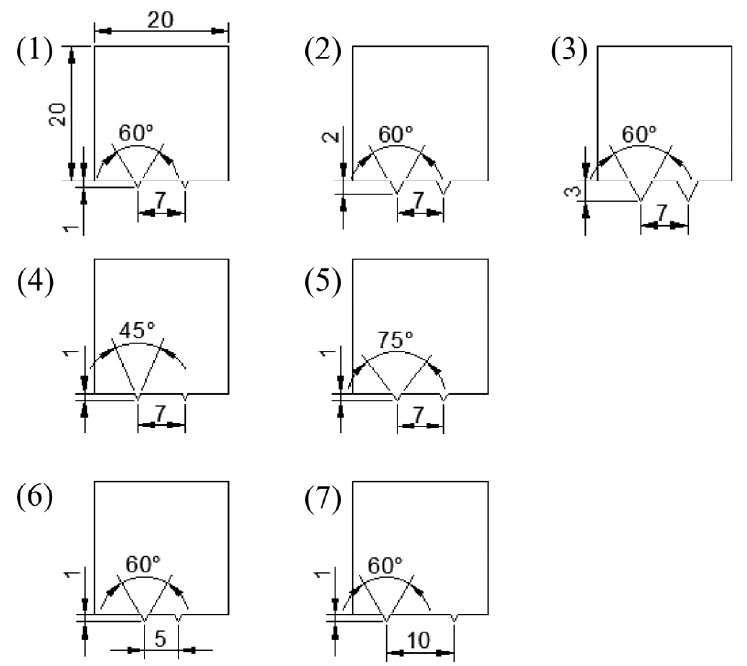
Figure 4. Seven types of shear indenter. ( 1 ) Shear indenter 1 ( 2 ) Shear indenter 2 ( 3 ) Shear indenter 3 ( 4 ) Shear indenter 4 ( 5 ) Shear indenter 5 ( 6 ) Shear indenter 6 ( 7 ) Shear indenter 7. Table 2. Parameters of seven types of shear indenter.